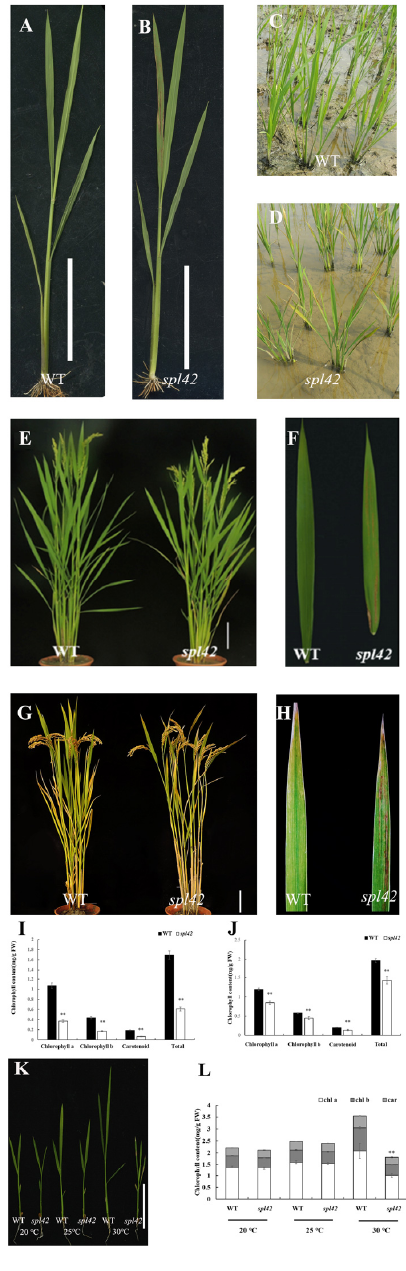
Figure 1. Phenotypic characterization of the spl42 mutant. ( A , B ) Individual images of wild type (WT, left) and spl42 (right) at the four-leaf stage. Scale Bar = 5 cm. ( C , D ) Field phenotypes of wild type (left) and spl42 (right) two weeks after transplanting into the field. ( E , F ) Images of individual plants (left) and flag leaves (right) of wild type and spl42 at heading stage. Scale Bar = 10 cm. ( G , H ) Images of individual plants (left) and flag leaves (right) of wild type and spl42 at the mature stage. Scale Bar = 10 cm. ( I , J ) The chlorophyll contents of wild type and spl42 at the seedling (left) and heading stages (right). Error bars represent ± SD ( n = 3). ( K ) Seedling phenotypes of wild type and spl42 under different temperature treatments. Scale Bar = 5 cm. ( L ) The chlorophyll content of wild type and spl42 under different temperature treatments. Chl a: Chlorophyll a; Chl b: Chlorophyll b; Car: total carotenoids. Error bars represent ± SD ( n = 3). Asterisks indicate a significant difference between the wild type and spl42 plants by Student’s t -test, ** p <